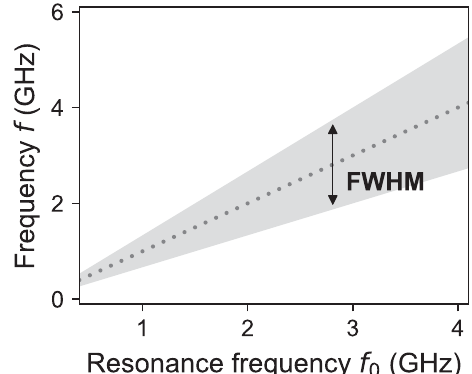
GHz.FIG. 7. SAW-dispersion relation for aluminium IDTs on a GaAs substrate. We show the resonance frequency for IDTs having different periodicity — here expressed as wave number 1 = λ ¼ k= 2 π . The points are extracted from Gaussian fits of 0 distinct peaks in the transmission data (reflection data for the case of 8 GHz) from a network analyzer measurement.